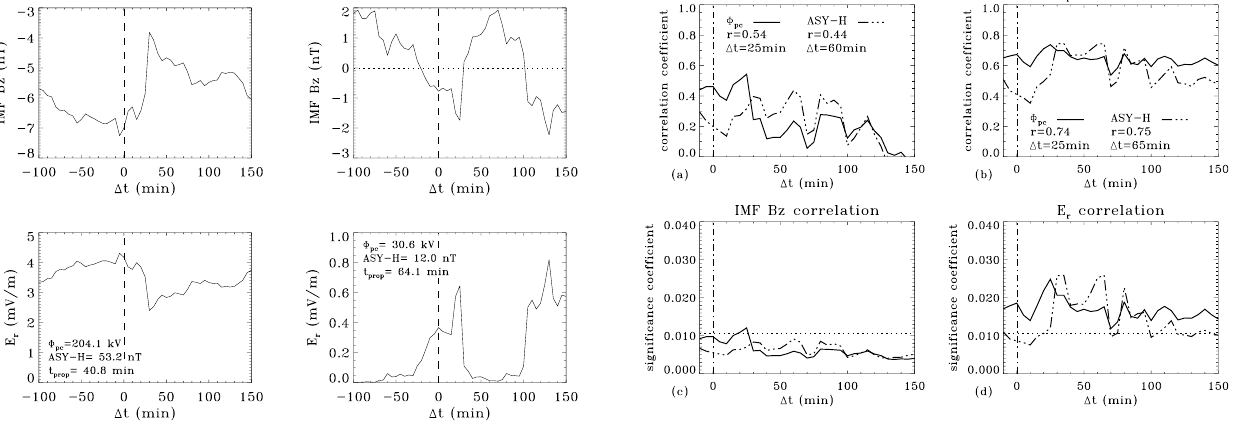
Fig. 2. The time shifted IMF B z and reconnection electric field E r measured at the ACE spacecraft are plotted versus time lag 1t . A negative time lag refers to future solar wind conditions. Note the different vertical ranges on the y -axes.